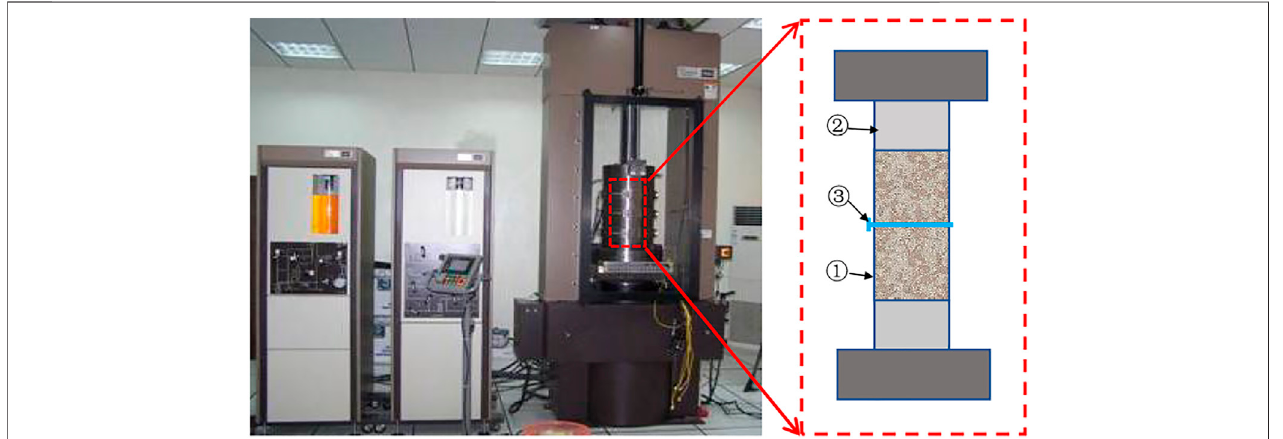
FIGURE 4 | Testing device of MTS 815 ( ① shale sample; ② pressure head; ③ circumferential strain gauge).